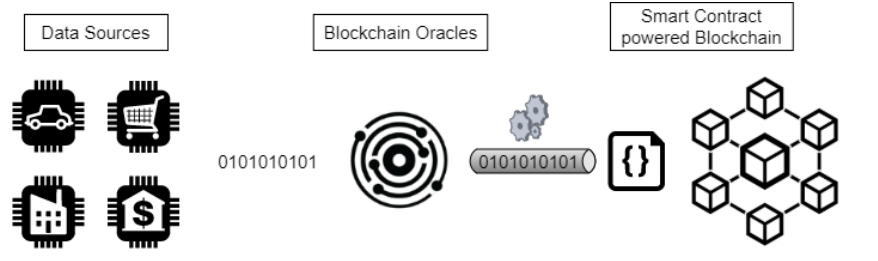
Figure 2. Blockchain Oracles